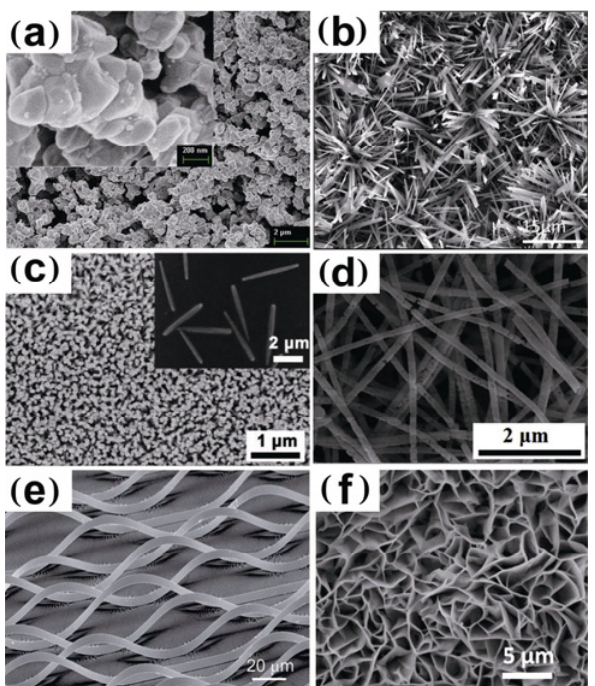
Fig. 2 Structures of inorganic piezoelectric